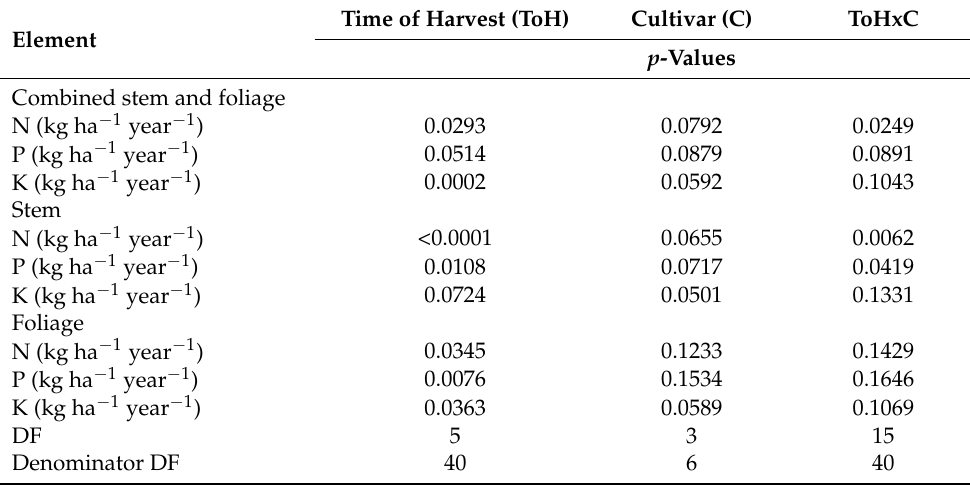
Table 4. Summary of analyses of variance for the effects of time-of-harvest treatment (ToH), cultivar (C), and ToHxC on total nutrient removal (stem + foliage) on the 2007 harvest.